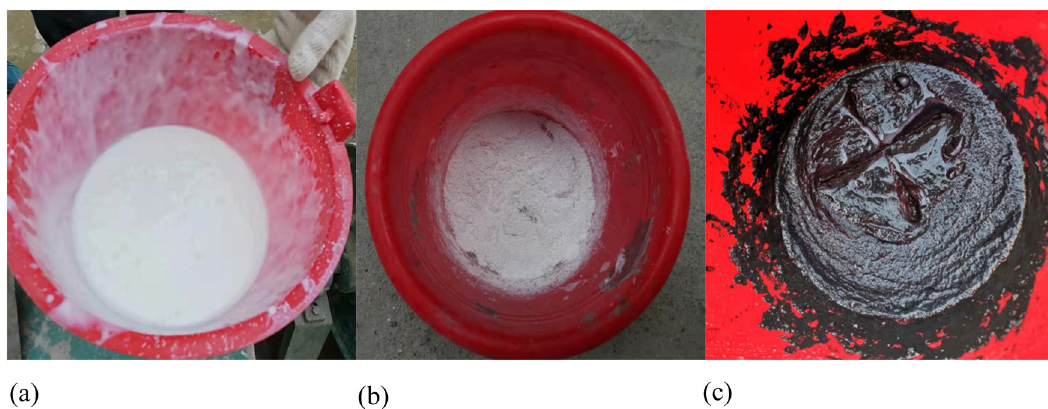
Figure 5: Nanomaterial dispersion. ( a ) NS dispersion, ( b ) NC dispersion, and ( c ) CNF